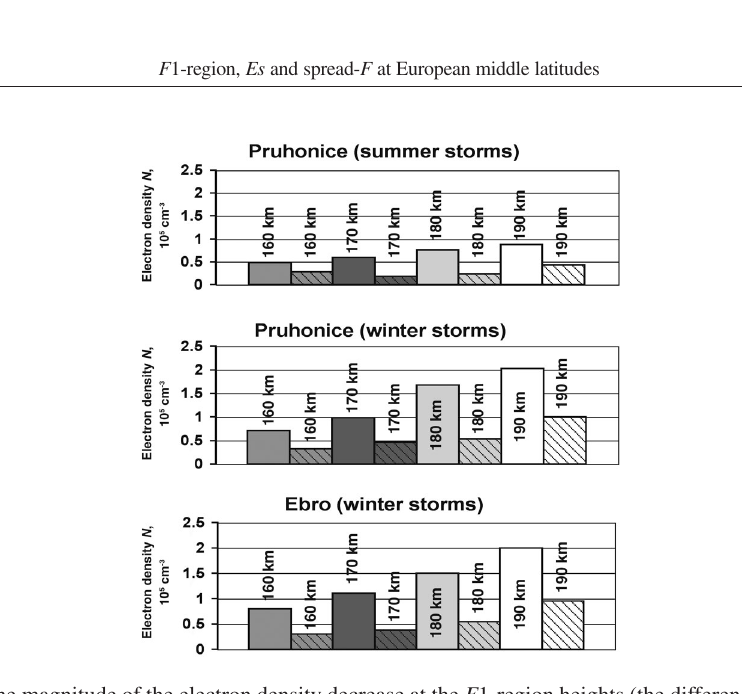
Fig. 12.3. The magnitude of the electron density decrease at the F 1-region heights (the difference between pre- storm quiet days and the storm main phase at 11:00-13:00 UT) for the super storm of July 2000 versus the May 1997, June 1998, August 1998 strong storms for Pruhonice (top panel) and for the super storm of March/April 2001 versus the strong storms of January 1996, February 1998, March 1998 and November 1998 (middle panel – Pruhonice; bottom panel – Ebro). Full columns – super storms; dashed columns – strong storms.